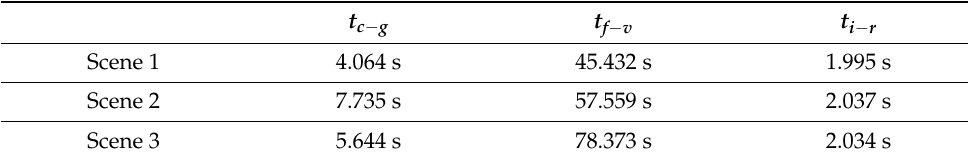
Table 6. The running time of several algorithms.